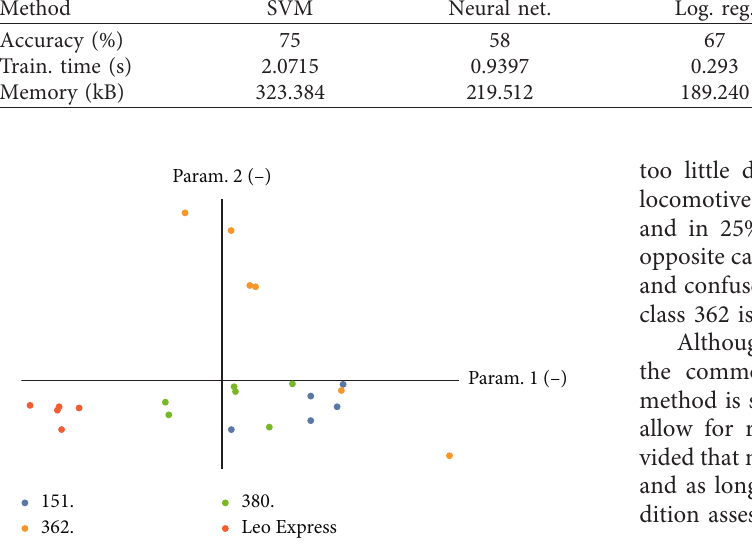
Figure 10: Visualization of clustering of scalar features for indi- vidual train passages sorted by train